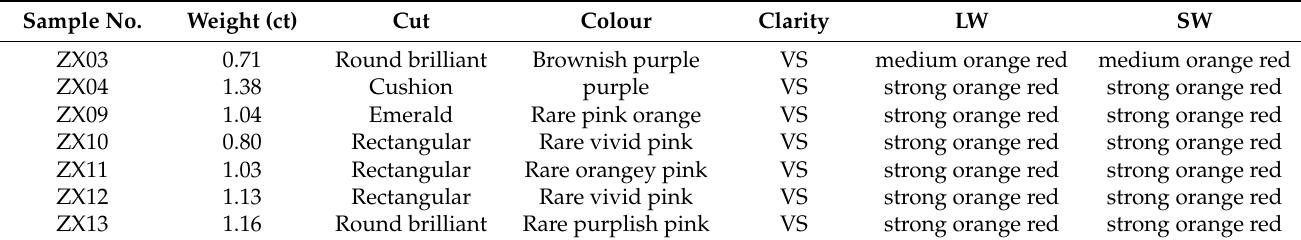
Table 1. The gemological information about the pink CVD-grown synthetic diamonds studied in this research. Sample No. Weight (ct) Cut Colour Clarity LW